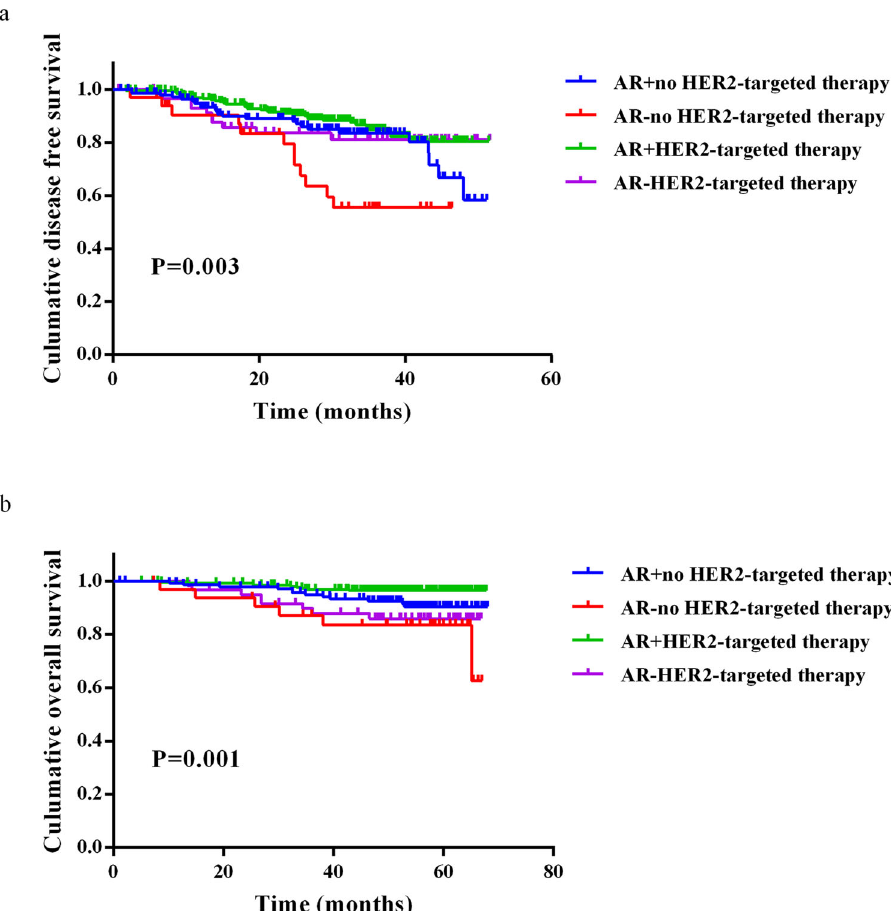
Fig. 2 Survival in patients with HER2 + nonmetastatic IDC according to AR expression and HER2-targeted therapy. Kaplan – Meier curve for DFS ( a ) and OS ( b ) of breast cancer patients strati fi ed by AR status and HER2-targeted